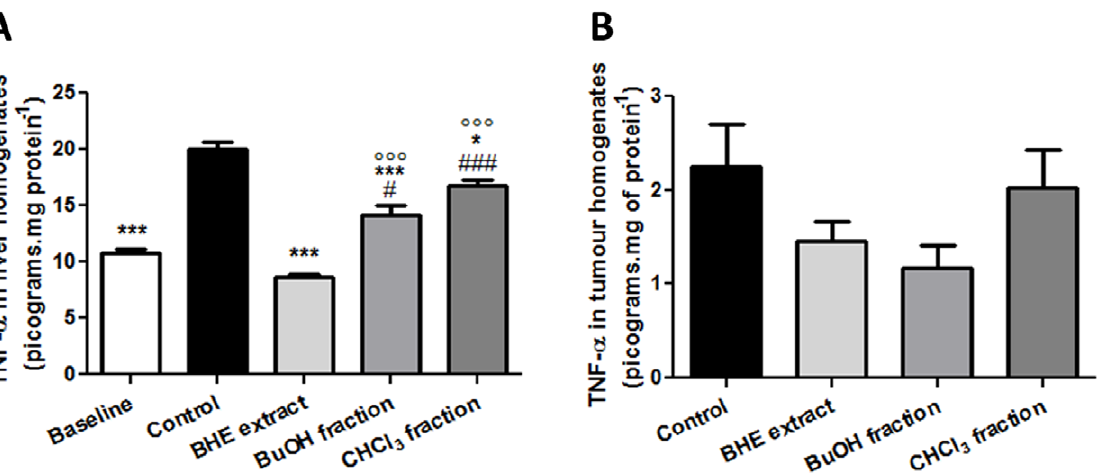
Figure 7. Levels of the inflammatory cytokine TNF- a in the hepatic (A) and tumour (B) homogenates of Walker-256 tumour-bearing rats treated with U.tomentosa BHE extract or its two fractions (BuOH and CHCl 3 ). Symbols: *** p , 0.001 as compared to the control group;